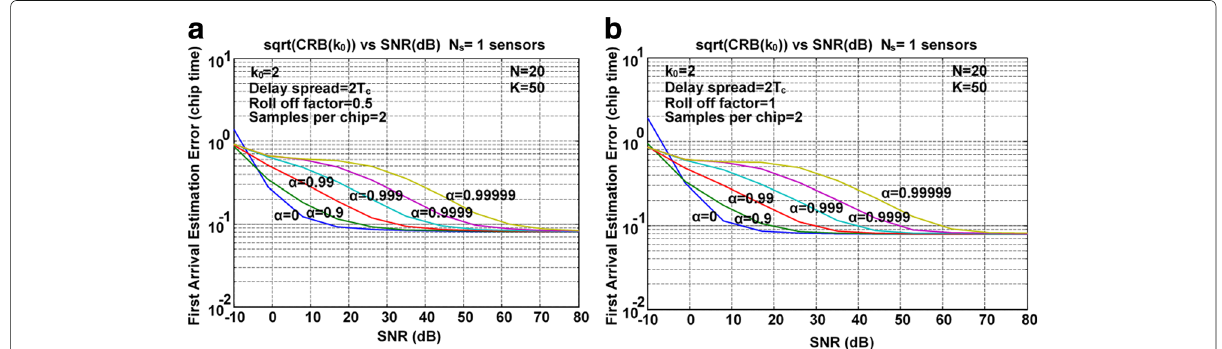
Fig. 5 CRB of the first arriving path k 0 for different values of the SNR. Results are provided for different values of the temporal correlation α , delay spread set to 2 T c , and two different roll-off factors. One sensor and 50 channel vector estimates are available. The sampling rate set to twice the chip rate. a Left: set to 0.5. b Right: β set to